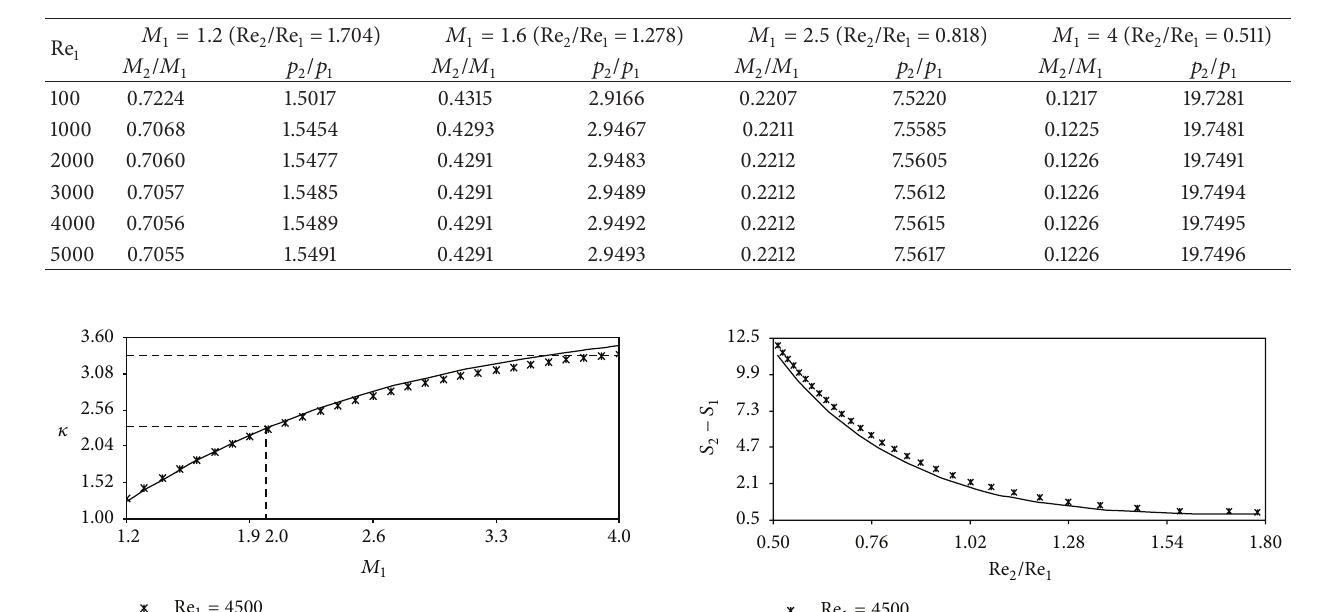
Table 3: Reynolds number, Re